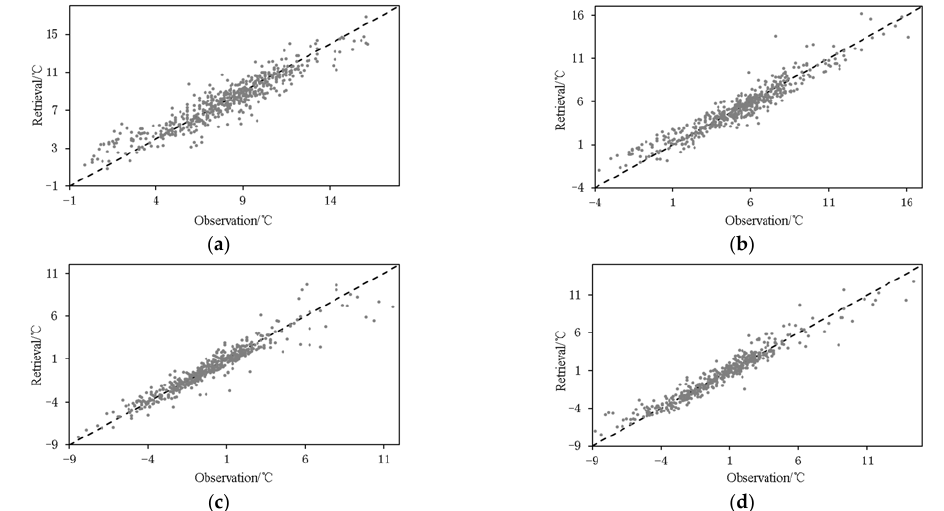
Figure 8. Scatter plot for observations and retrievals of road surface (bridge deck) temperature using stepwise regression model at road surface station 1 ( a ), road surface station 2 ( b ), bridge deck station 1 ( c ), and bridge deck station 2 ( d ).